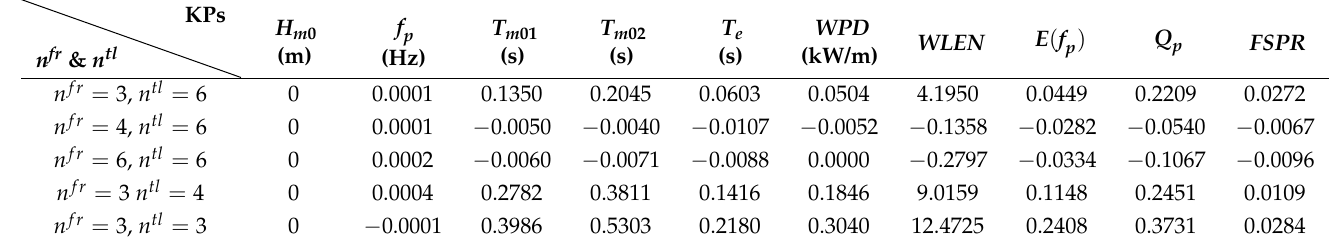
Table 6. Mean absolute error (MAE) of the KPs derived from the original and the reconstructed (obtained under different strategies of n fr and n tl ) partitions at check point B2. The MAE values were derived from all the partitions identified, and the values illustrated under the other n fr and n tl combinations are relative to those obtained under the setting of n fr = 3 and n tl = 6.